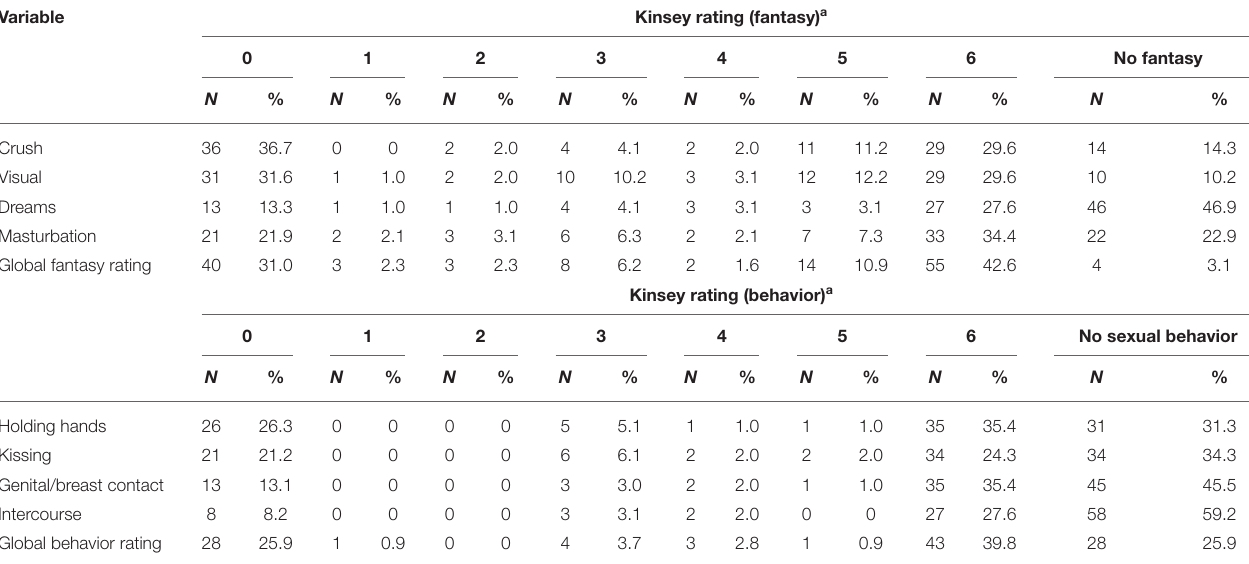
TABLE 2 | Kinsey ratings for sexual orientation in fantasy and behavior.